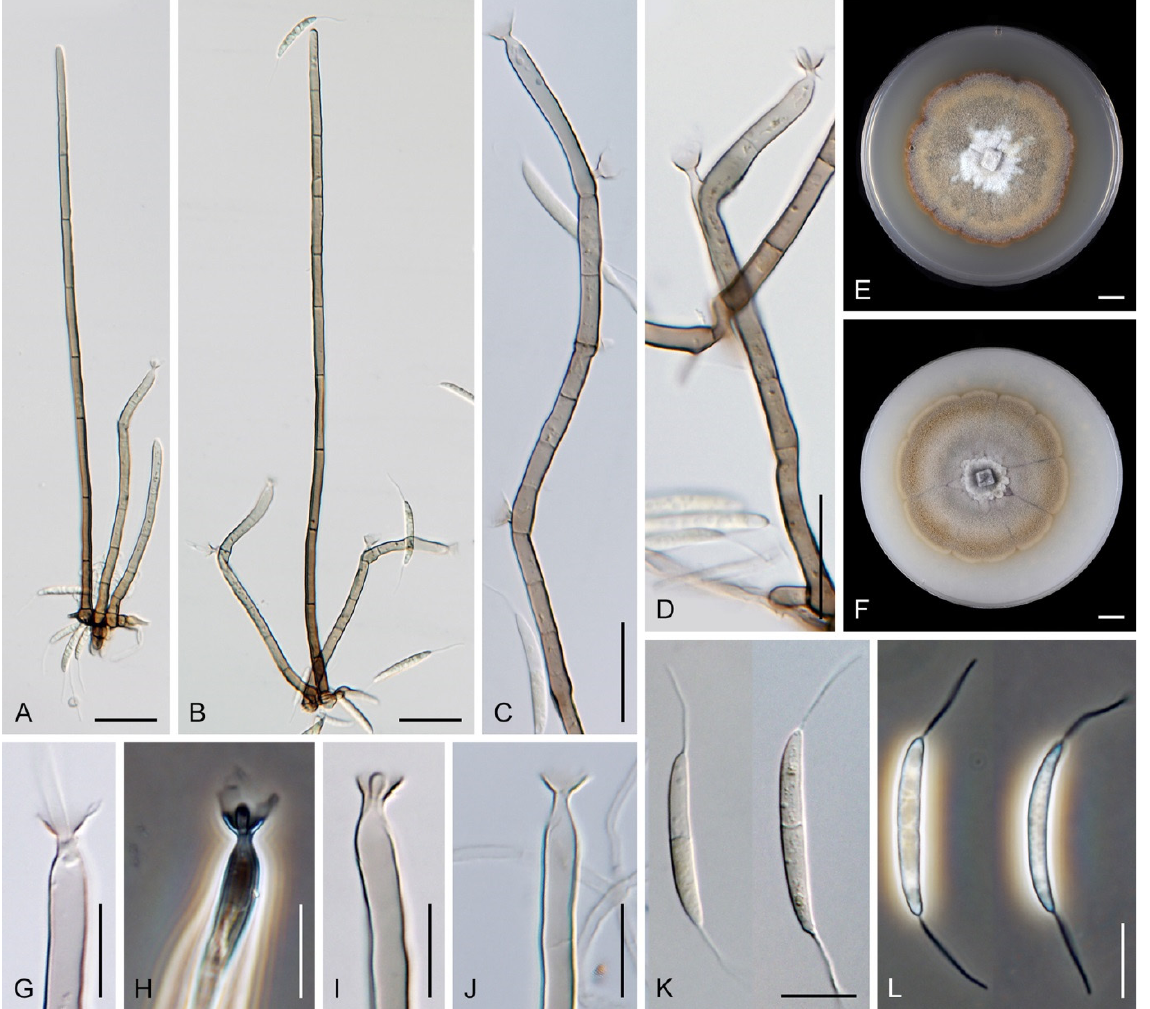
Figure 38. Stilbochaeta malaysiana (IMI 312436 ex-type). ( A , B ) Setae and conidiophores ( C , D ) conidiophores with conidiogenous cells, in detail ( E , F ) colonies ( G – J ) tip of the conidiogenous cells with collarettes ( K , L ) conidia. Images: ( A – D , G – L ) on CMD after 4–6 weeks ( E ) on MLA after 4 weeks ( F ) on OA after 4 weeks. Scale bars: ( A , B ) 25 μ m; ( C , D ) 20 μ m; ( E , F ) 1 cm; ( G – L ) 10 μ m.